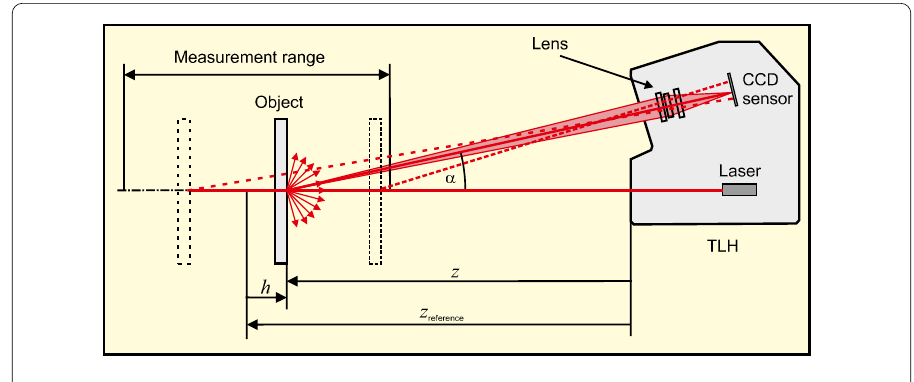
Figure 1 Schematic drawing of the working principle of a triangular laser head (TLH)